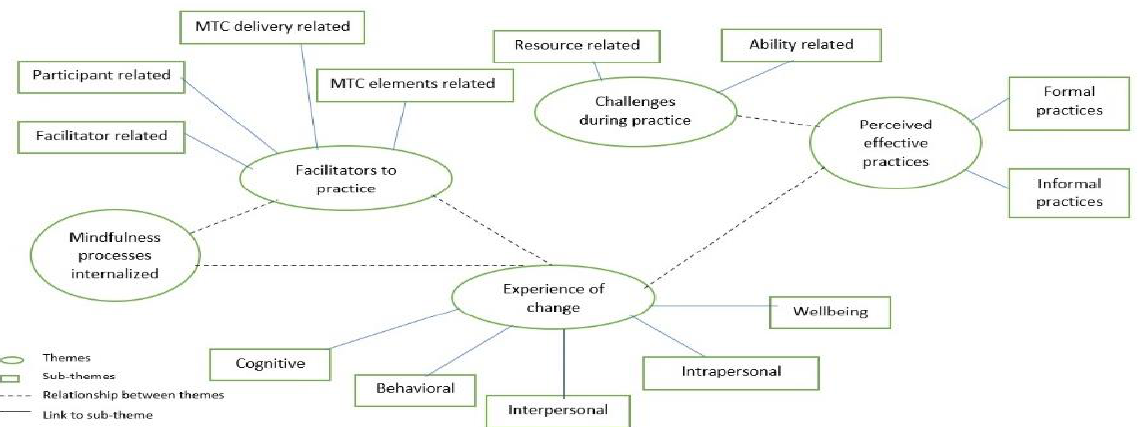
Figure 2. Thematic map demonstrating the five themes from reflexive thematic analysis of acceptability interviews.